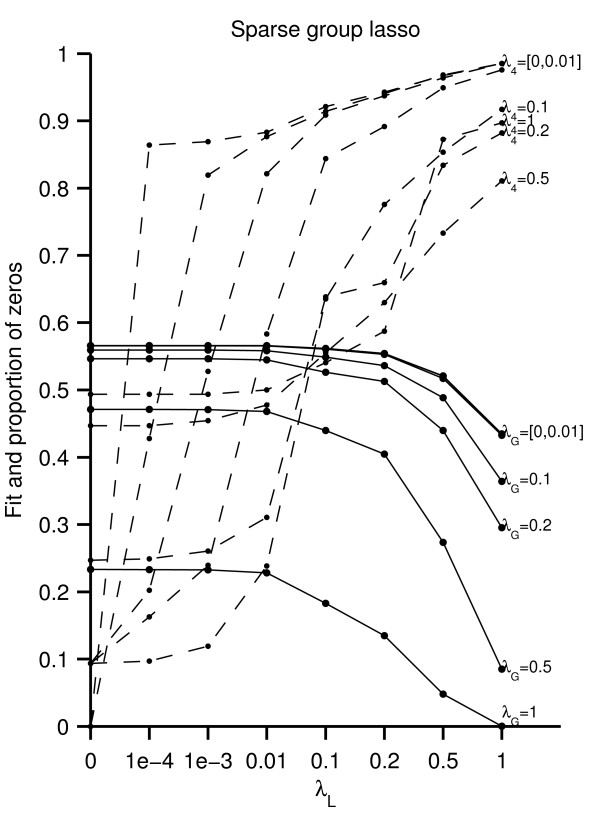
Sparse group lasso. Fit (full lines) and proportion of zeros (dashed lines) for the sparse group lasso. The different lines refer to different values of the group lasso penalty.